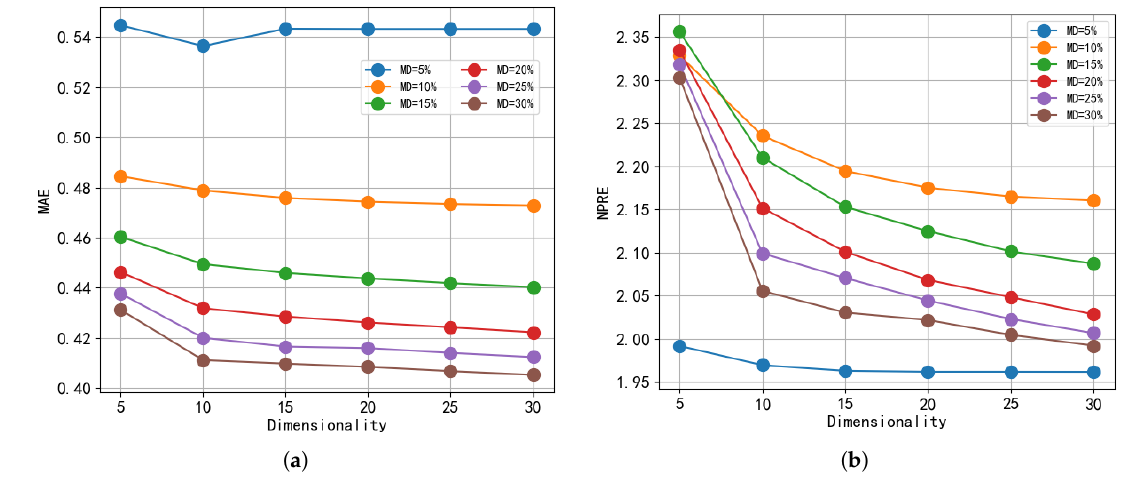
Figure 4. Impact of dimensionality. ( a ) MAE; ( b )